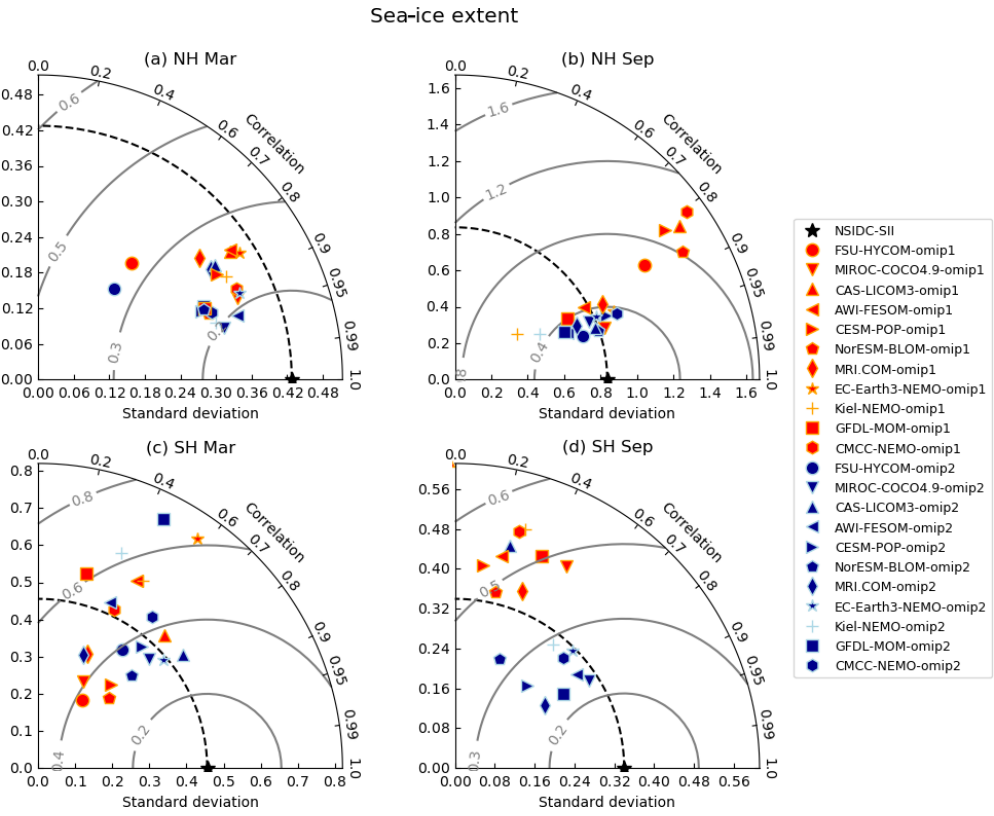
Figure 23. Taylor diagram of the interannual variation of sea-ice extent in both hemispheres relative to NSIDC-SII. (a) March (winter) and (b) September (summer) sea-ice extent in the Northern Hemisphere. (c) March (summer) and (d) September (winter) sea-ice extent in the Southern Hemisphere. Standard deviations are expressed in units of 10 6 km 2 .